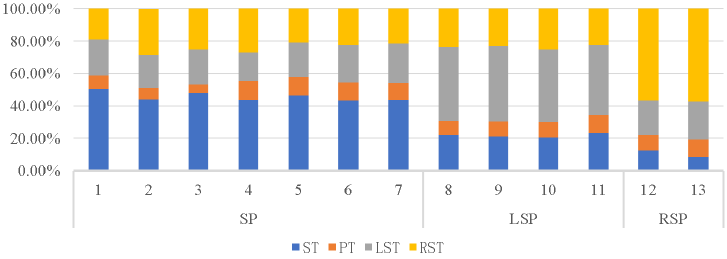
Figure 8. Percentage of sleep time in subjects with different sleeping-position preferences.